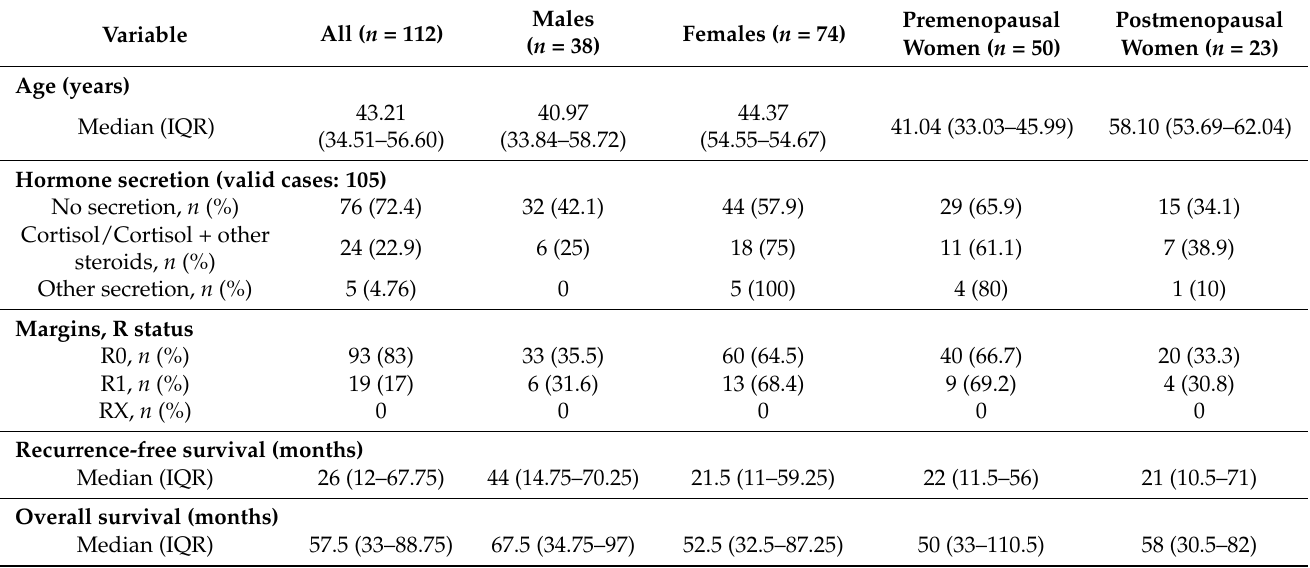
Table 1. Demographic and clinical characteristics of the 112 enrolled patients.